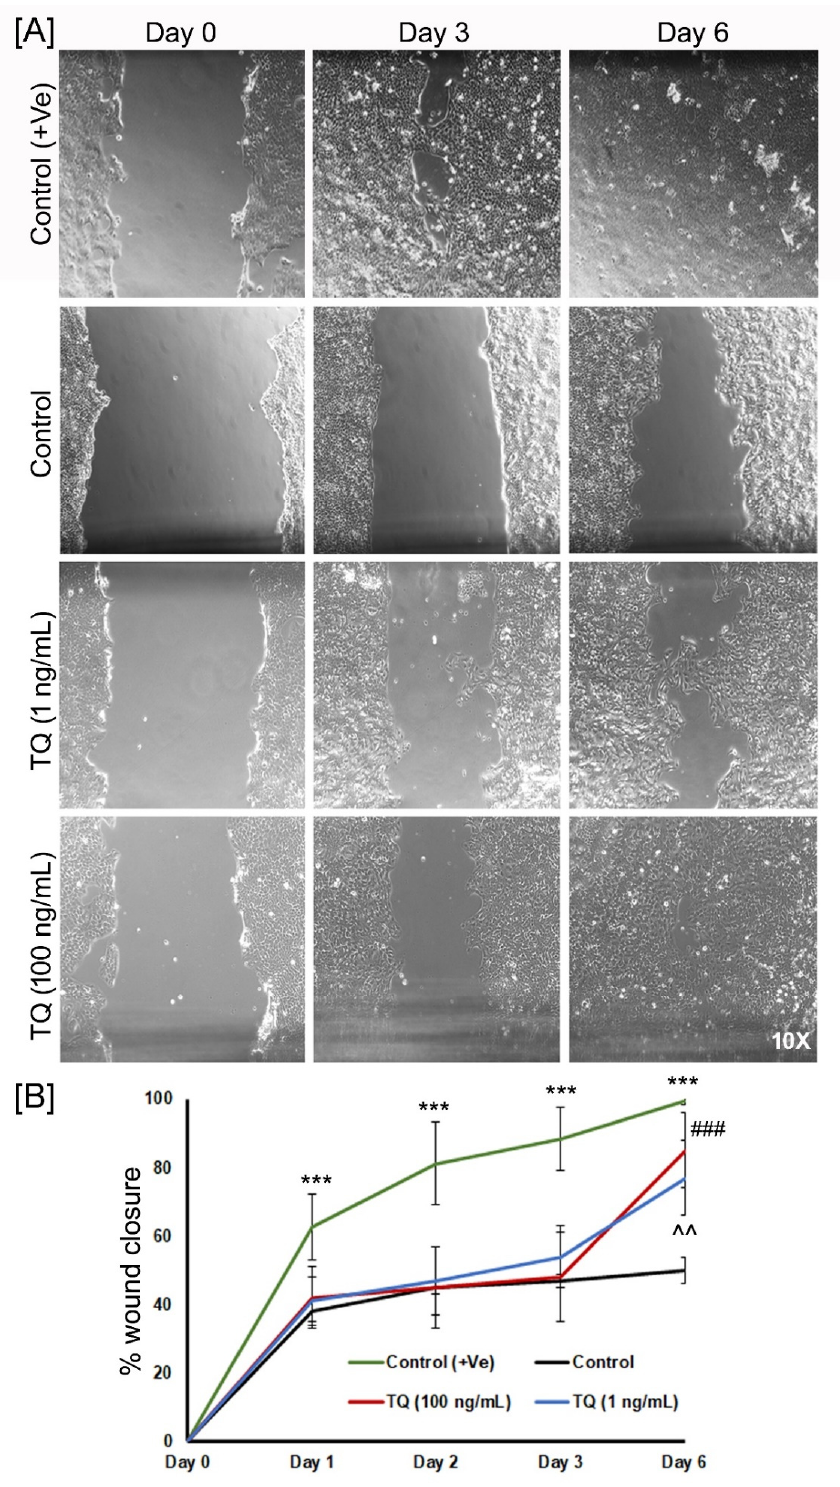
Figure 7. E ff ect of TQ treatment on the wound healing of keratinocytes using scratch assay. ( A ) Representative micrographs (10 × ) from Control ( + Ve), Control, 1 ng / mL, and 100 ng / mL of TQ showing the original wound at day 0 and the wounds after 3 and 6 days of keratinocyte cell migration; ( B ) Quantitative analysis of wound closure as a function of time. The wound area was determined as the wound area at a given time relative to the original wound area at day 0 ( n = 5–6). *** p < 0.001 (Control vs. Control + Ve), ˆˆ p < 0.01 (Control vs. 1 ng / mL) and ### p < 0.001 (Control vs. 100 ng /